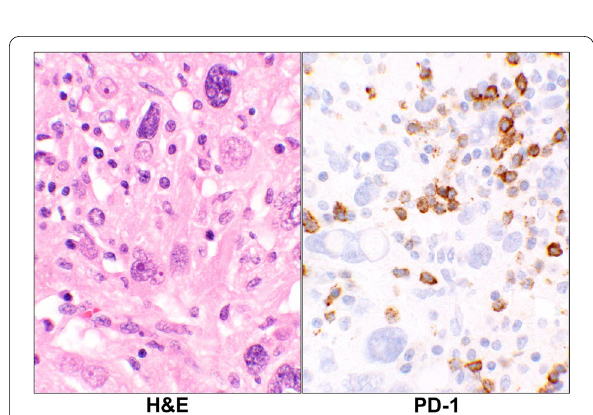
Fig. 4 PD-1 Reaction in Leiomyosarcoma. H&E stain of a case with primary leiomyosarcoma (case# 28, Additional Table 1) showing large malignant cells and scattered small lymphoid cells in the background. The corresponding PD-1 stain shows a positive staining of some of the lymphoid cells while the tumor as well as the remaining lymphoid cells are negative (40 objective). Abbreviations: H&E, × hematoxylin & eosin; PD-1, programmed cell death protein